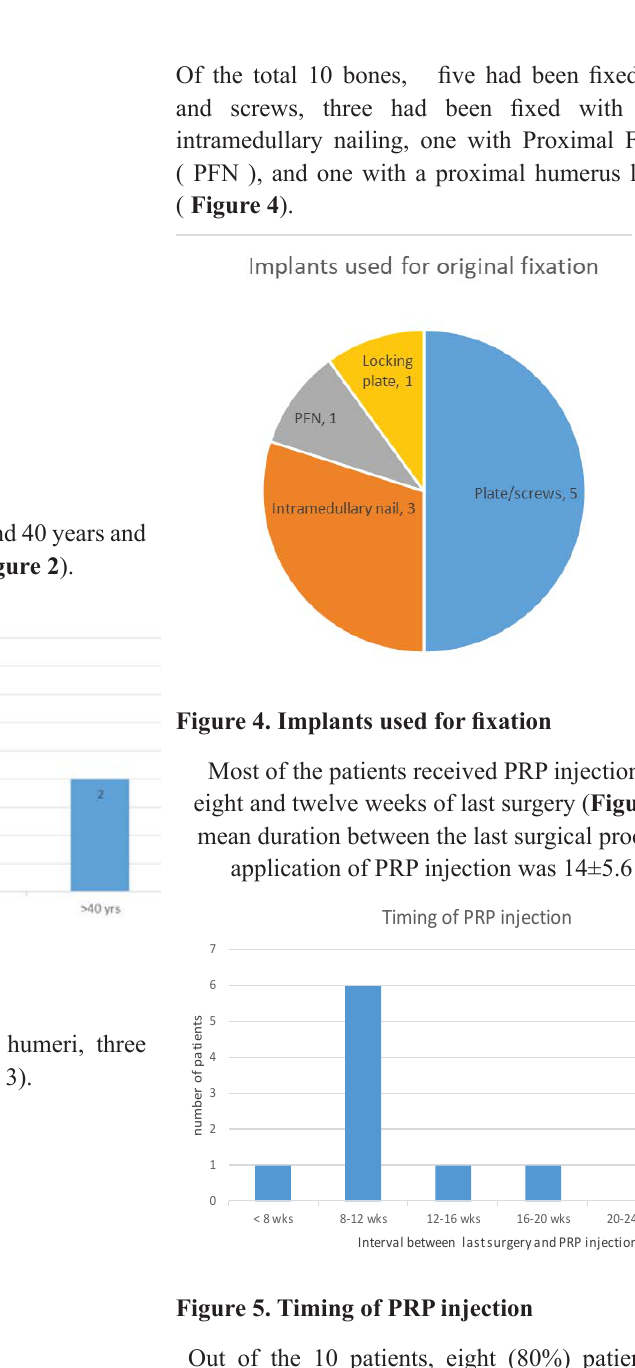
Figure 5. Timing of PRP injection Out of the 10 patients, eight (80%) patients got their fractures united. Two patients did not unite and had to (cid:88)(cid:81)(cid:71)(cid:72)(cid:85)(cid:74)(cid:82)(cid:3)(cid:68)(cid:81)(cid:82)(cid:87)(cid:75)(cid:72)(cid:85)(cid:3)(cid:86)(cid:88)(cid:85)(cid:74)(cid:76)(cid:70)(cid:68)(cid:79)(cid:3)(cid:83)(cid:85)(cid:82)(cid:70)(cid:72)(cid:71)(cid:88)(cid:85)(cid:72)(cid:3)(cid:90)(cid:76)(cid:87)(cid:75)(cid:3)(cid:85)(cid:72)(cid:89)(cid:76)(cid:86)(cid:76)(cid:82)(cid:81)(cid:3)(cid:191)(cid:91)(cid:68)(cid:87)(cid:76)(cid:82)(cid:81)(cid:3) and bone grafting. The mean time for union, in the patients (cid:90)(cid:75)(cid:82)(cid:3)(cid:71)(cid:76)(cid:71)(cid:3)(cid:88)(cid:81)(cid:76)(cid:87)(cid:72)(cid:15)(cid:3)(cid:90)(cid:68)(cid:86)(cid:3)(cid:191)(cid:89)(cid:72)(cid:3)(cid:90)(cid:72)(cid:72)(cid:78)(cid:86)(cid:3)(cid:68)(cid:73)(cid:87)(cid:72)(cid:85)(cid:3)(cid:87)(cid:75)(cid:72)(cid:3)(cid:76)(cid:81)(cid:77)(cid:72)(cid:70)(cid:87)(cid:76)(cid:82)(cid:81)(cid:17)(cid:3) There were no cases of re-fracture, compartment syndrome, or infection at the injection site. All of the patients had painful subcutaneous swelling following the procedure, which subsided after a few